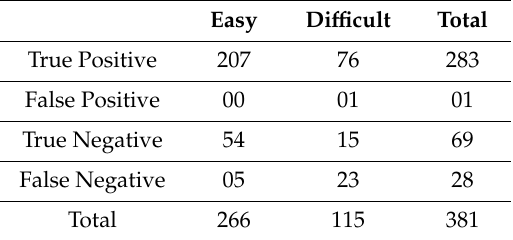
Table 2. Results of the manual inspection of the